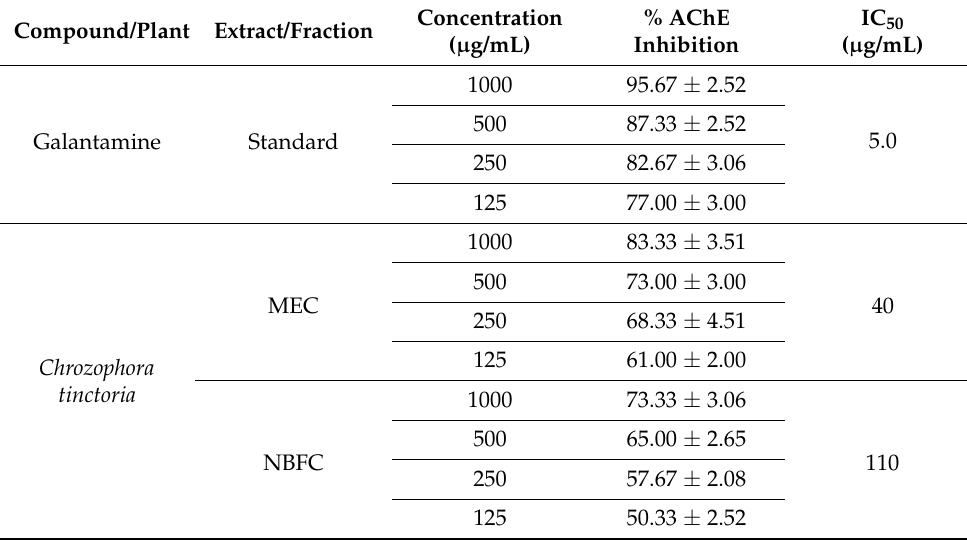
Table 3. Percent inhibition of acetylcholinesterase by MEC and NBFC.